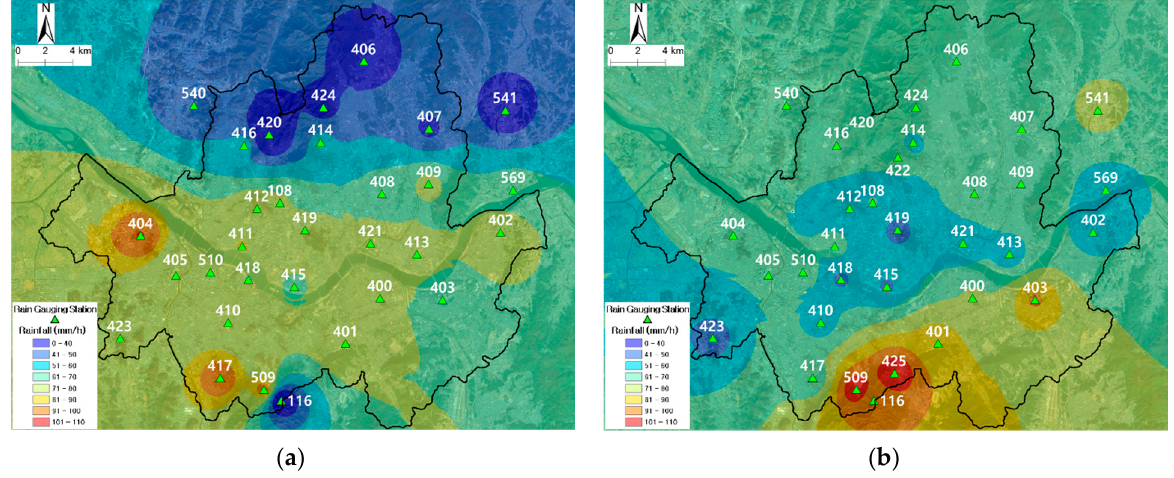
Figure 10. Rainfall interpolation results by year: ( a ) September 2010; ( b ) July 2011. Figure 9. Rainfall interpolation results by year: ( a ) September 2010; ( b ) July